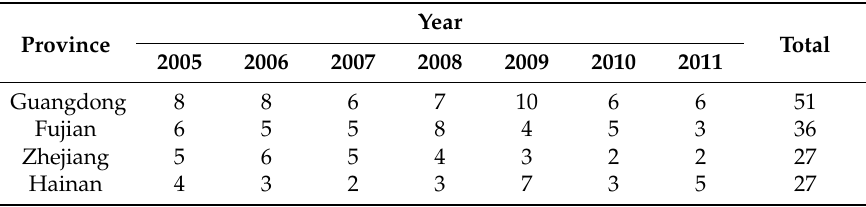
Table 2. The number of TCs that affected each province over the study